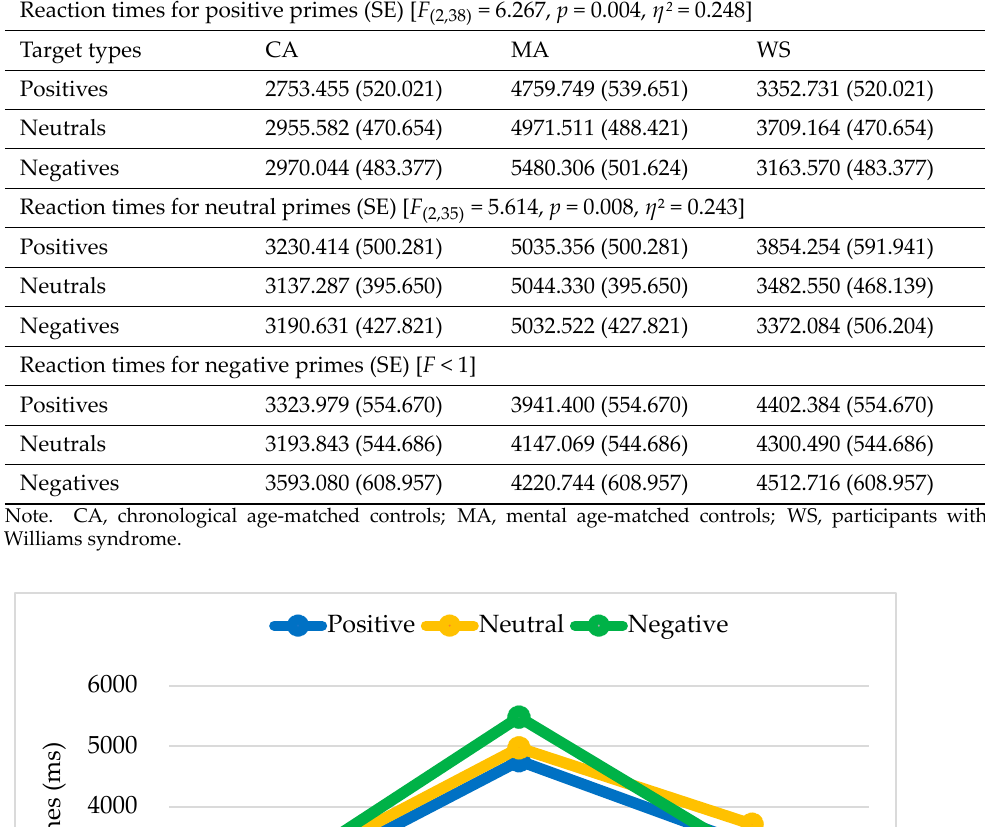
Table 3. Matrix of reaction times for the three groups in responses to three types of targets given the three types of primes.